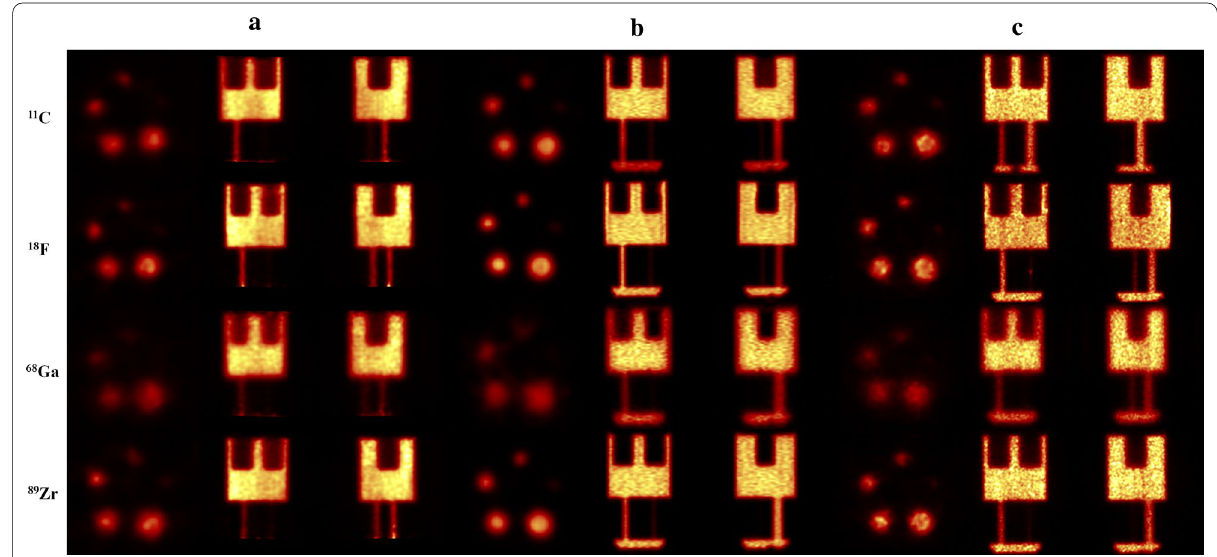
Fig. 1 Image quality from one plane in the rod region of the NEMA phantom with different preclinical PET/CT systems. The systems shown are a RAYCAN, b Inveon and c Molecubes. Slight differences in the noise level between various radionuclides in the images within a system can be seen. The 18 F and 89 Zr have similar whereas appearance, whereas the positron range is the major contributing factor to the blurred appearance of the images with 68 Ga. All images have been scaled between 0 and 1.25 times the mean activity of the uniform